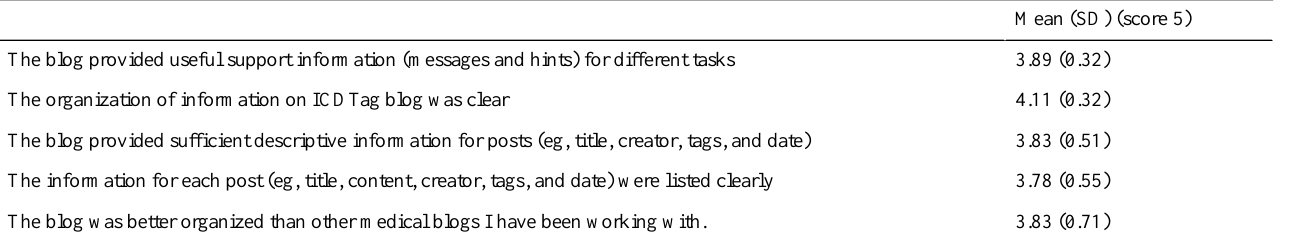
Table 8. Results of the information organization evaluation.